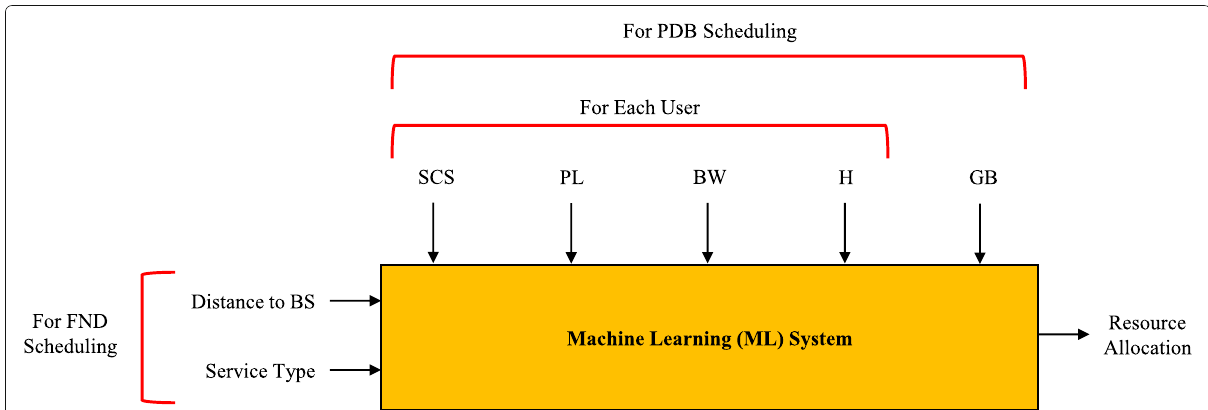
Fig. 7 An example ML block diagram. Distance to BS and service type are inputs for FND scheduling. Subcarrier spacing (SCS), PL, BW, and wireless channel ( H ) are used as inputs of PDB scheduling for each UE. Guard band (GB) between two numerologies is used as another input for PDB scheduling